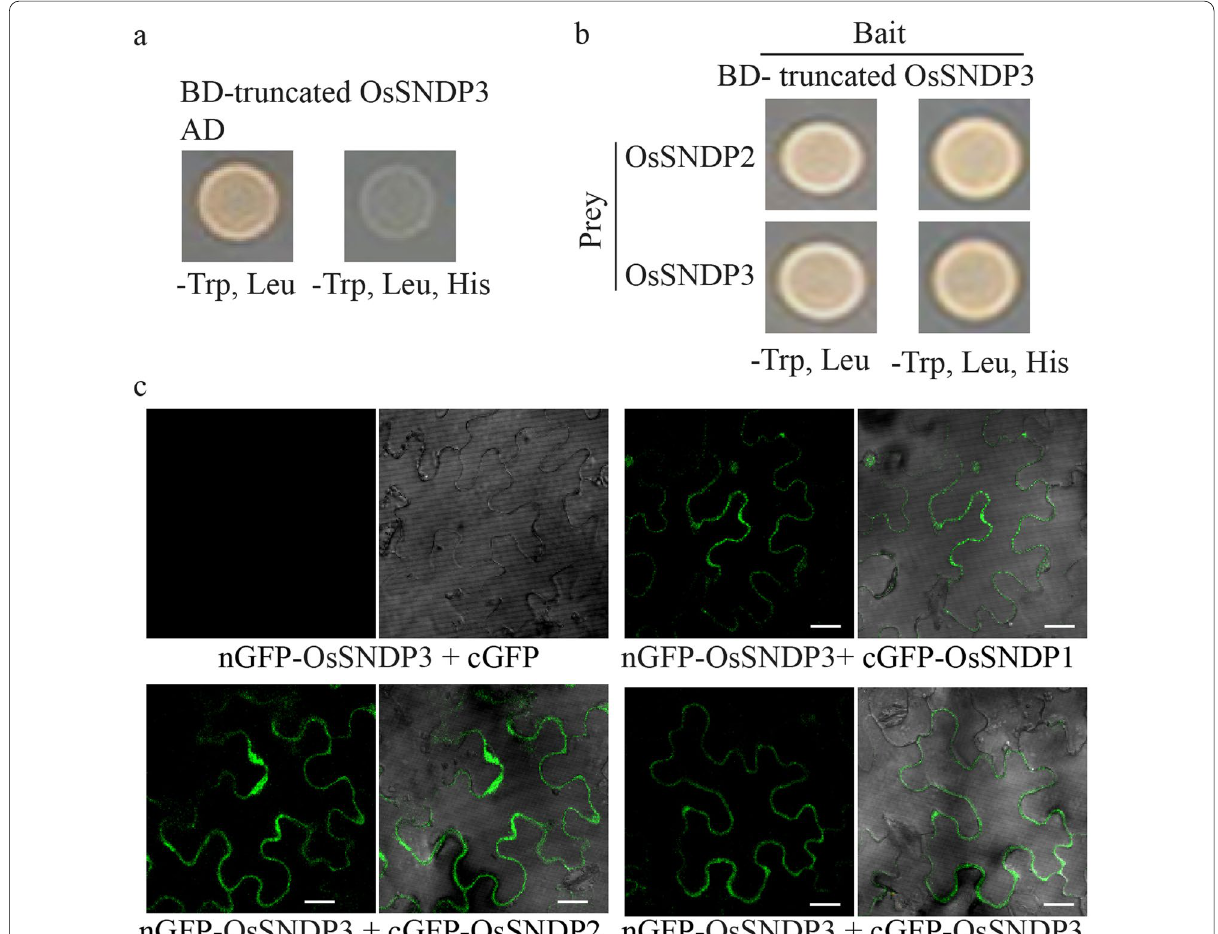
Fig. 4 Interaction between OsSNDP3 and class I nodulin domain‑containing proteins. a Yeast self‑activation assay of truncated OsSNDP3. b Yeast two‑hybrid analysis to confirm the interaction between OsSNDP3 and identify prey proteins. c Interactions between OsSNDP3 and class I nodulin domain‑containing proteins by BiFC. Fluorescent signals were detected from a cell expressing nGFP‑OsSNDP3/cGFP, nGFP‑OsSNDP3/ cGFP‑OsSNDP1, nGFP‑OsSNDP3/cGFP‑OsSNDP2, and nGFP‑OsSNDP3/ cGFP‑OsSNDP3. Bars